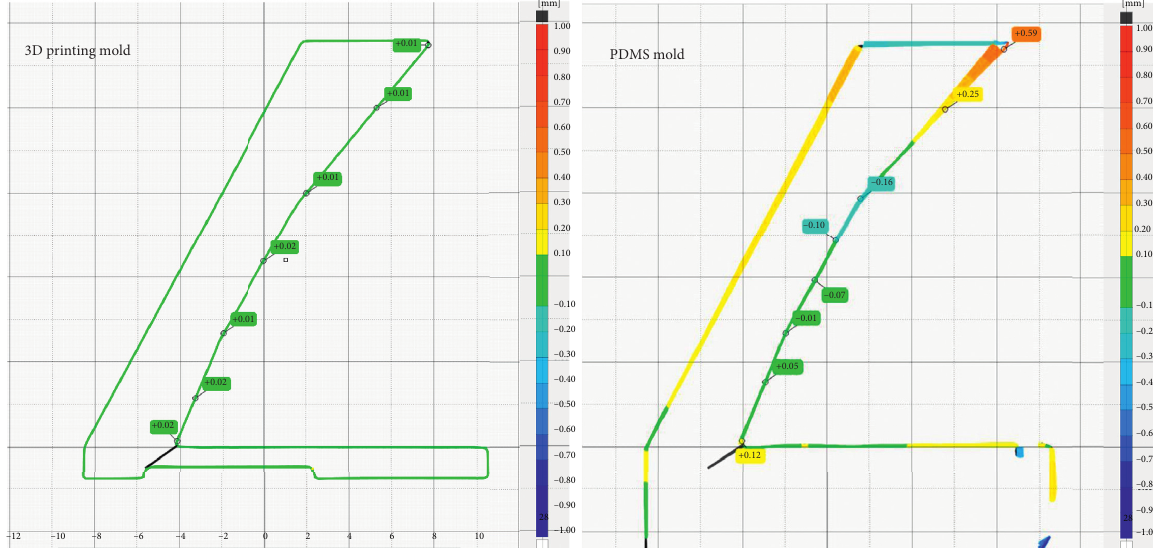
Figure 19: Finished product shape profile measurement.